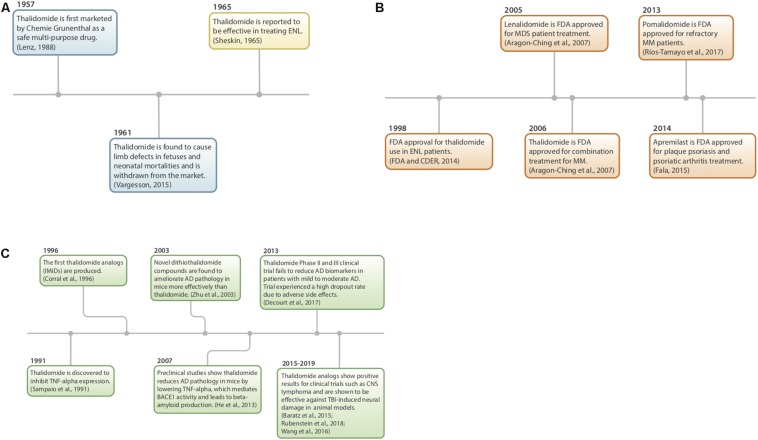
(A–C) History of thalidomide and IMiDs. (A) Thalidomide discovery, market withdrawal, and repurposing (Sheskin, 1965; Lenz, 1988; Vargesson, 2015). (B) FDA approval of IMiDs (Aragon-Ching et al., 2007; FDA and CDER, 2014; Fala, 2015; Ríos-Tamayo et al., 2017). (C) Preclinical studies using IMiDs (Sampaio et al., 1991; Corral et al., 1996; Zhu et al., 2003; Baratz et al., 2015; Wang et al., 2016b; Decourt et al., 2017; Liu T. et al., 2017; Rubenstein et al., 2018).